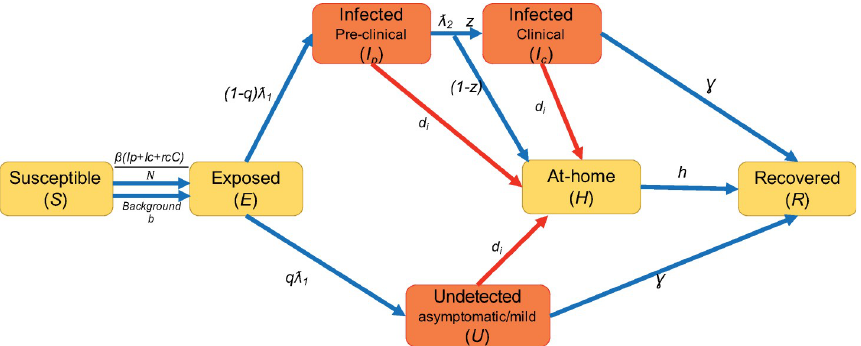
Fig 1. Schematic for compartmental transmission model. Orange boxes represent classes of individuals that contribute to transmission, and that are also detectable via PCR. Blue arrows represent processes that are modeled as differential equations in the deterministic model, and refer to transmission and disease progression processes. Red arrows represent screening and testing measures in the model, which occur at specific intervals. Red and blue arrows are included in the stochastic model. Parameters that determine the rate at which individuals transition between compartments are defined in Table A in the S1 Appendix.